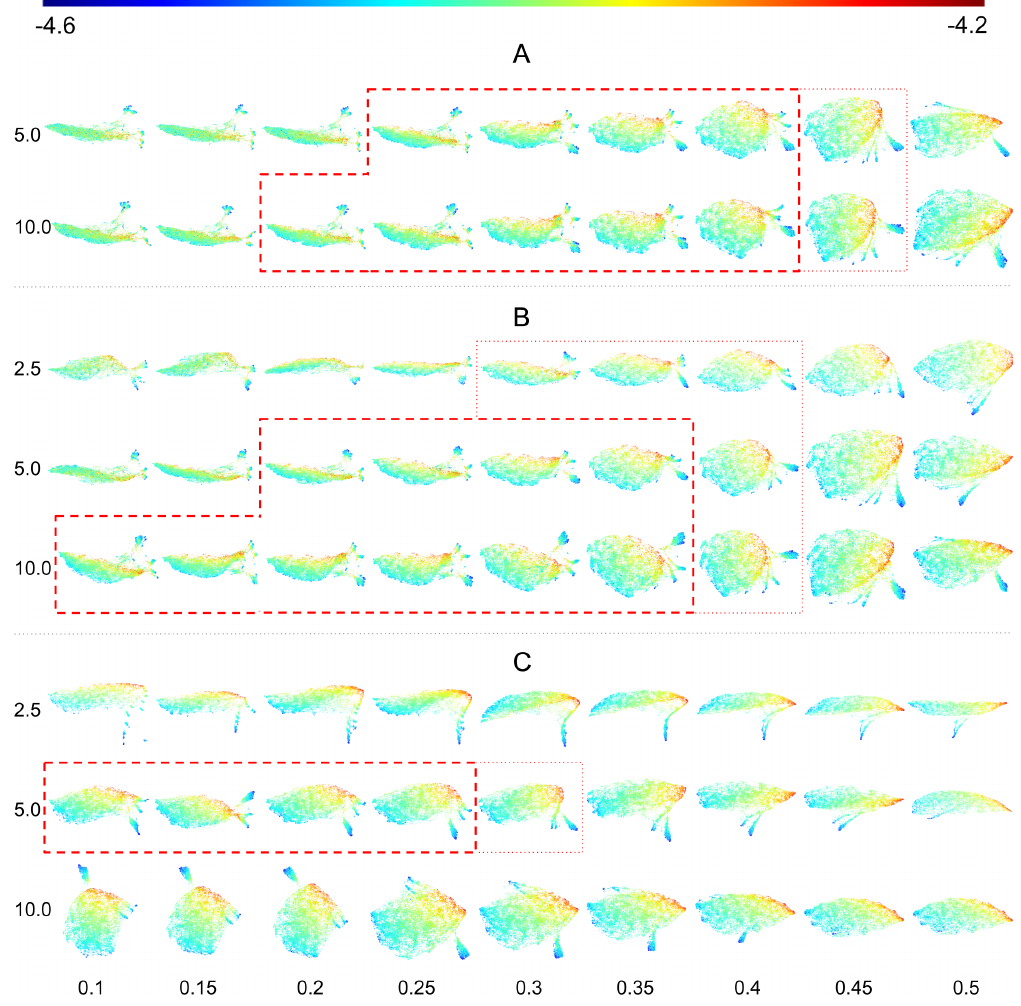
FIG. 8. 2D SHEAP maps for 10 000 minima (prior to similarity check) on the LJ 38 PES, described using SOAP with various ; l 15 , 9, 12,6, and 8,4, respectively. r parameters. (A), (B), and (C) show results for n is consistent across each row, values max max ¼ cut given on the far left in σ . σ is consistent across each column, values given at the bottom in σ . Projections use a perplexity of 15, with LJ LJ R 0 computed by Eq. (B1). The circles representing each structure are colored according to energy per atom in Lennard-Jones units; see the color bar at the top of the figure. Basin volumes are represented by the area of each circle. Maps in the bold, dashed, red perimeters represent “ suitable ” SOAP parameter choices, producing the same key features as Fig. 6. Maps in the faded, dashed, red perimeters also show these features but less